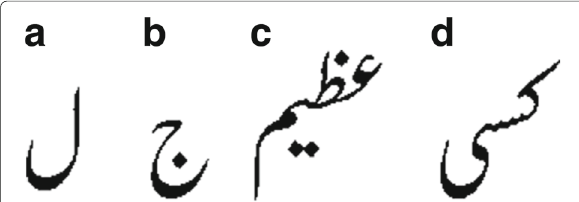
Fig. 4 Complete ligatures comprising: a Single-character primary ligature, b single-character primary and secondary ligature, c Multi-character primary and secondary ligatures, and d Multi-character primary